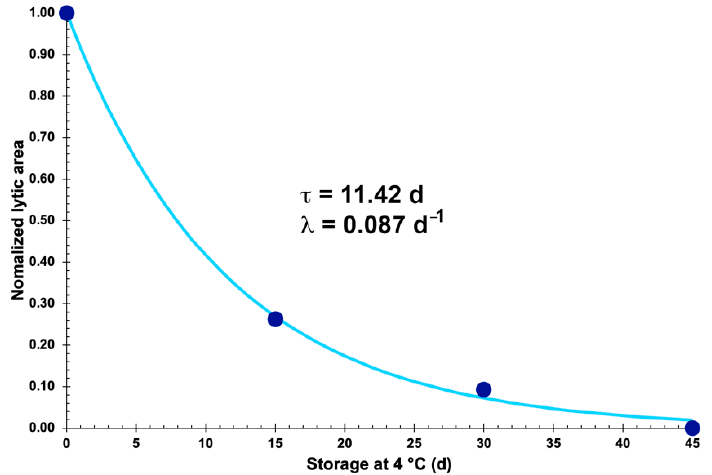
Figure 19. Results from the non-linear fitting of an exponential decay model (A ( t ) /A ( o ) = e − ( t/ τ ) ) to the evolution of normalized lytic area promoted by the vaginal eggs along cold storage at 4 °C.